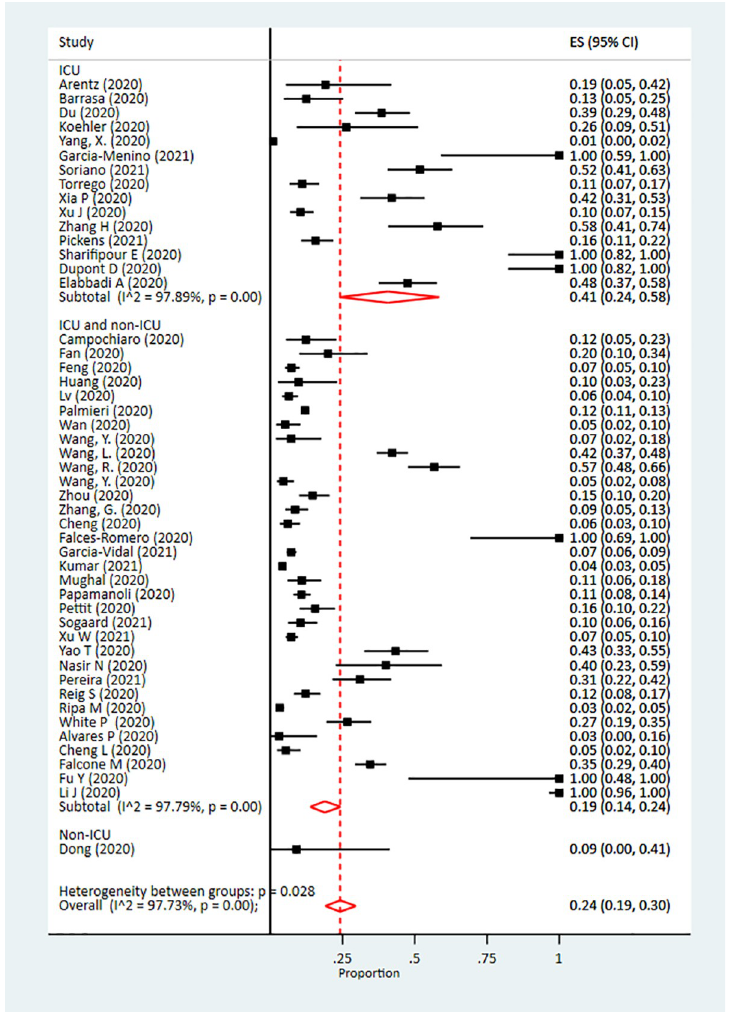
Fig 3. Forest plot of pooled prevalence of superinfection in patients infected with